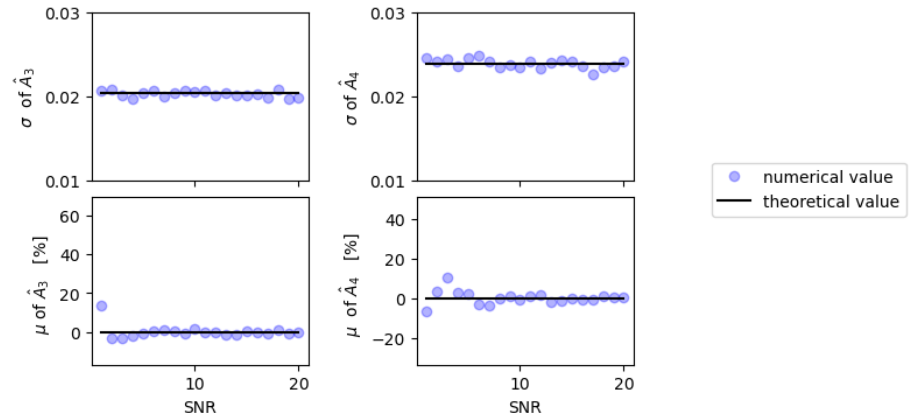
Figure 4. Bias and standard deviation of the quadrupole amplitudes A 3 ( left panel) and A 4 ( right panel). Theoretical predictions are drawn as continuous lines.